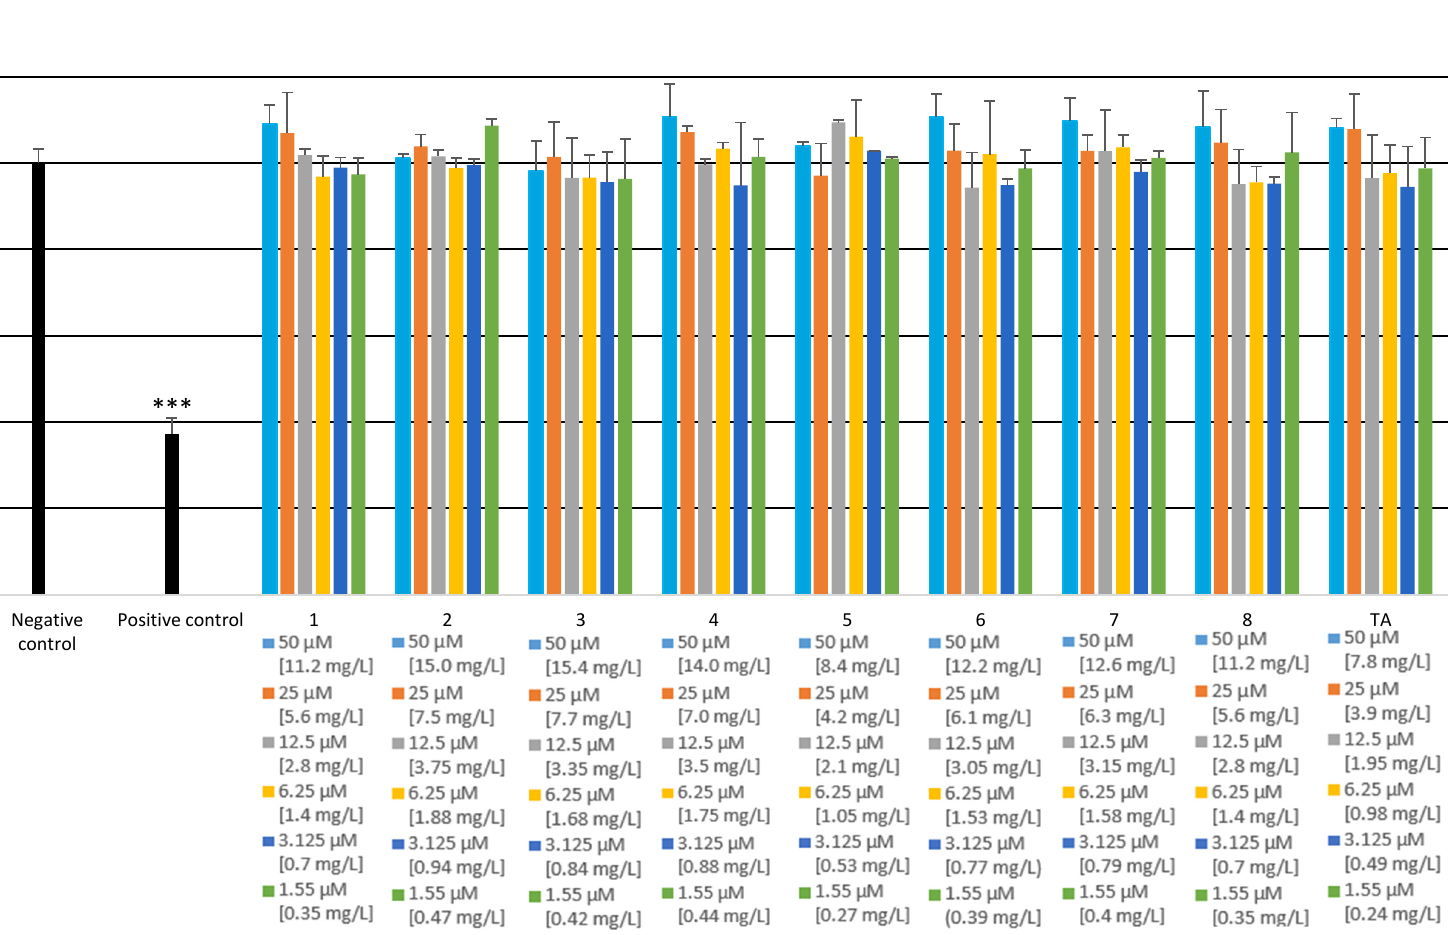
Figure 12. Cytotoxicity of the examined amides on SC cells. The XTT assay was used to assess the cytotoxicity of the tested amides. All of the experiments were performed in triplicate. Data are expressed as mean ± SD ( n = 3), *** p < 0.001 versus the negative control.